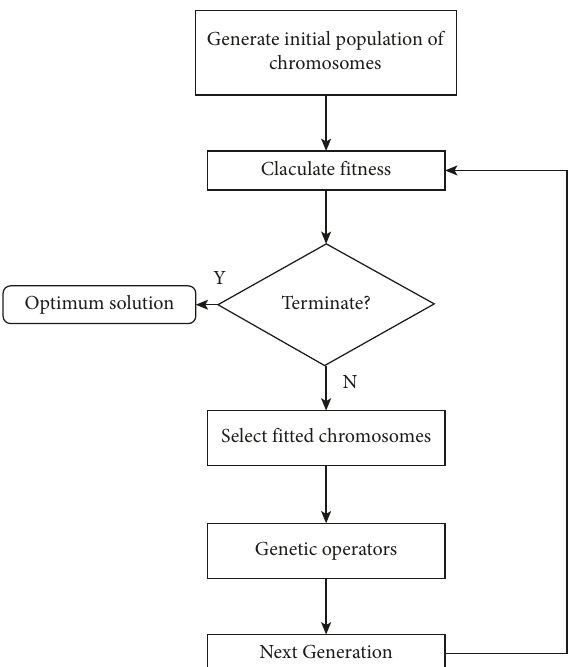
Figure 3: Genetic hyperparameter tuning